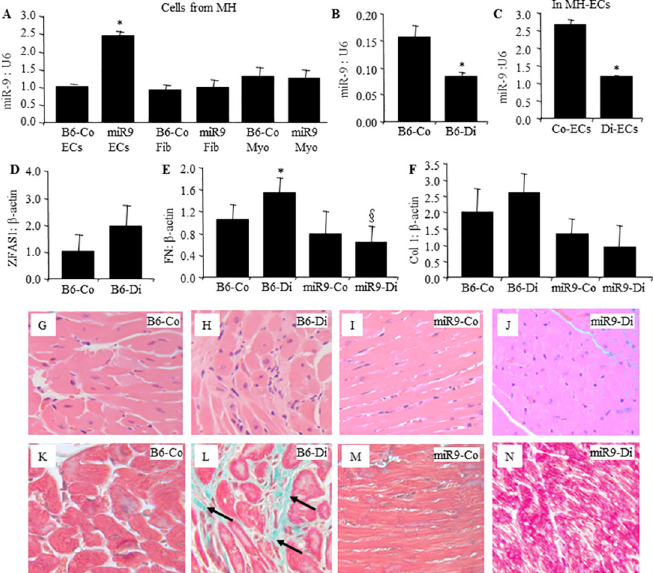
Fig 4. EC-specific miR-9 transgene (TG) alleviates diabetes-induced ECM (FN, Col1a1) production in vivo. A) RT-qPCR analyses of the cells from the cardiac tissues of the transgenic mice confirmed 2.5-fold increased miR-9 expression in the ECs but not in other cell types. Following two months of diabetes, reduced miR-9 were seen in the B) whole heart and in the C) ECs isolated from wild type diabetic mouse heart compared to the wild type non-diabetic controls, in association with increased expressions of (D) ZFAS1, ECM transcripts E) FN and F) Col1a1. Such diabetes induced ECM changes were prevented (E, F) in the miR-9 TG mice with diabetes. (G-J) hematoxylin and eosin and (K-N) corresponding trichrome staining showed increased focal fibrosis (arrow, green stain in L) in the hearts of wild diabetic animals compared with K) wild type control animals. Such diabetes-induced changes were not seen in the M. N) TG mice with or without diabetes. (Data expressed as a ratio to β -actin normalised to control; � P < 0.05, compared to B6-Co or Co-ECs; §P < 0.05, compared to B6-Di; B6-Co = Wild type non-diabetic controls; B6-Di = Wild type diabetic; miR9-Co = miR-9 transgenic control; and miR9-Di = miR-9 transgenic diabetic. MH = mouse heart. Myo = myocytes; fib = fibroblast; EC = endothelial cells. Co = control; Di = diabetic; n = 8/group. Same magnification for all micrographs).